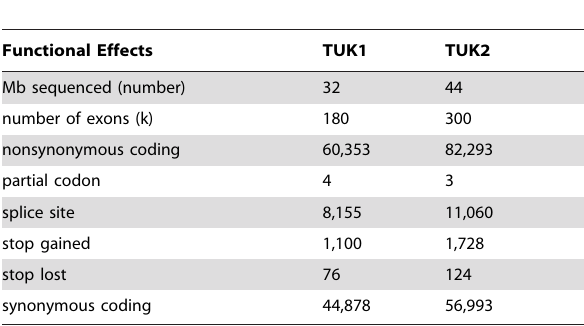
Table 2. Details of the SNVs identified in TUK1 and TUK2